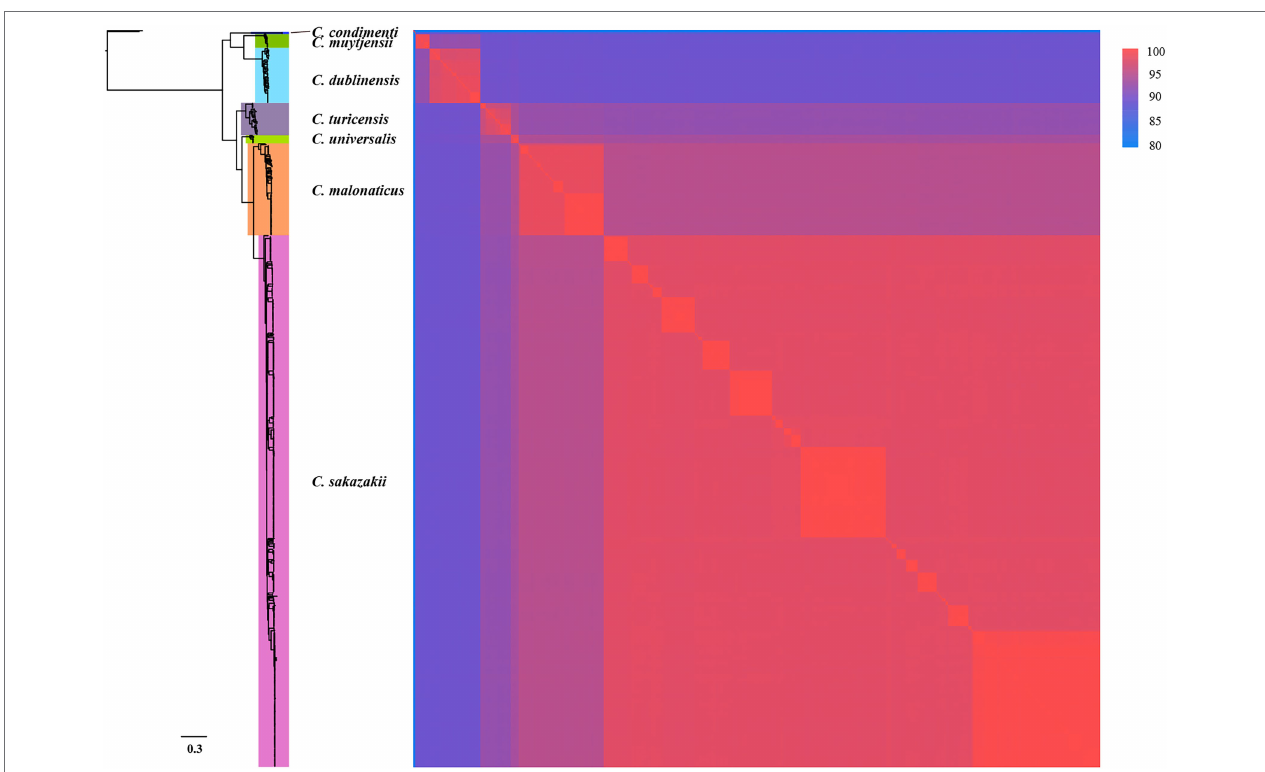
FIGURE 1 | Whole-genome phylogeny of seven species of Cronobacter . The maximum-likelihood phylogeny tree was constructed based on single-nucleotide polymorphisms extracted from 799 genomes, excluding those resulting from recombination (two Enterobacter cloacae strains were used as the outgroup). ANIb values of the 799 Cronobacter genomes was calculated using